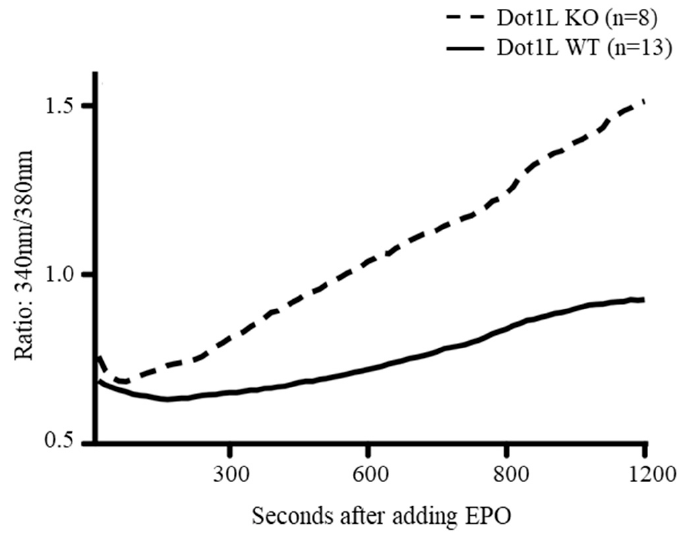
Figure 6. Accelerated and enhanced calcium influx in Dot1l KO erythroid progenitors. E10.5 Dot1l KO and wild-type yolk sac cells were stained, treated with EPO, and the Ca 2+ signals in individual cells were recorded using fluorescence microscopy. After EPO treatment, progenitor cells from Dot1l KO yolk sacs showed a sustained increase in Ca 2+ levels. Data are expressed as the mean ± SE; n > 6; * p < 0.05.